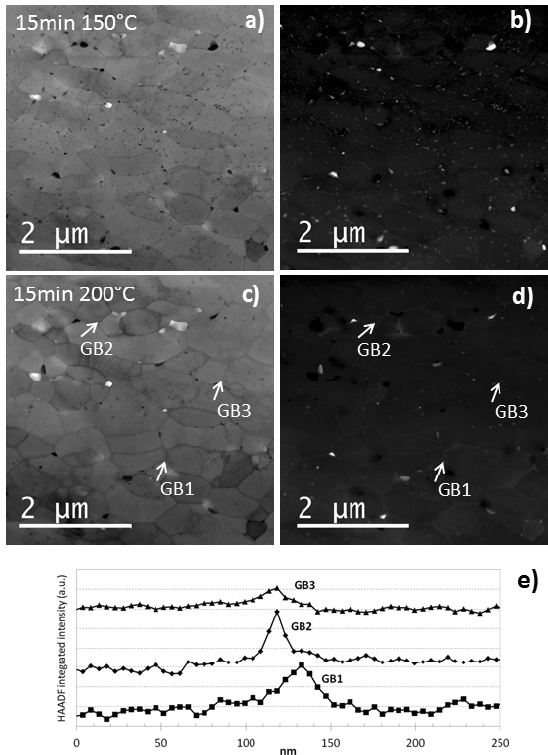
Fig. 2. (a, c) - STEM-BF and (b, d) - STEM-HAADF images showing the evolution of the microstructure of the Al-10Zn alloy processed by SPD followed by 15 min at 150 ° C and 15 additional minutes at 200 ° C (in-situ annealing showing the same region). (e) Line profiles computed across the three GBs pointed by arrows, and showing a significant increase of the HAADF signal that can be attributed to GB seg- regation of Zn or wetting layers at 200